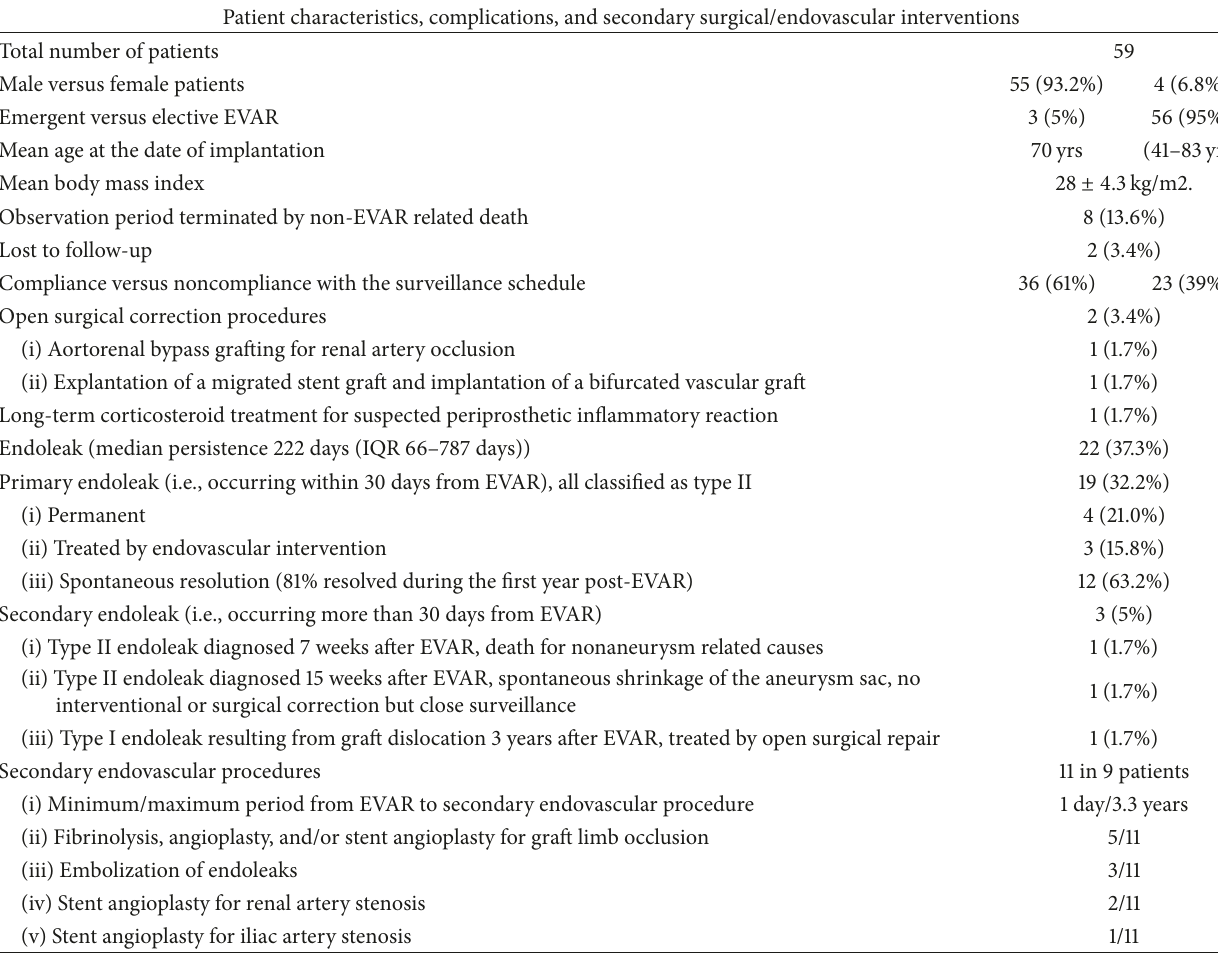
Table 1: Patient characteristics and details on occurrences during the observation period. Patient characteristics, complications, and secondary surgical/endovascular